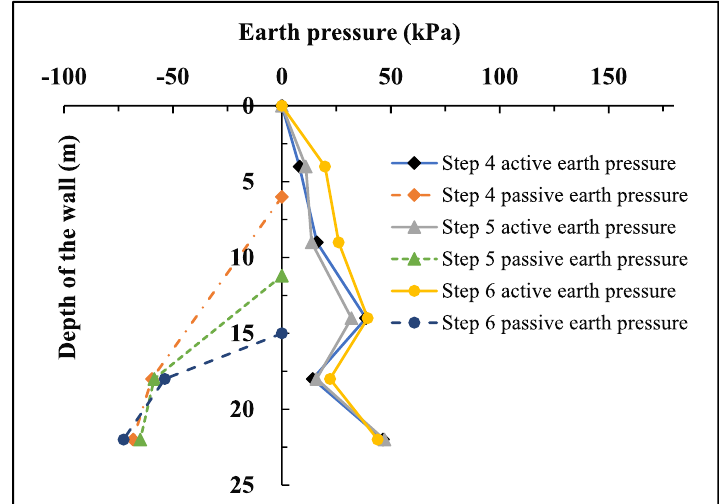
Figure 12. Earth pressure distribution of wall No. 1 from Step 4 to Step 6.